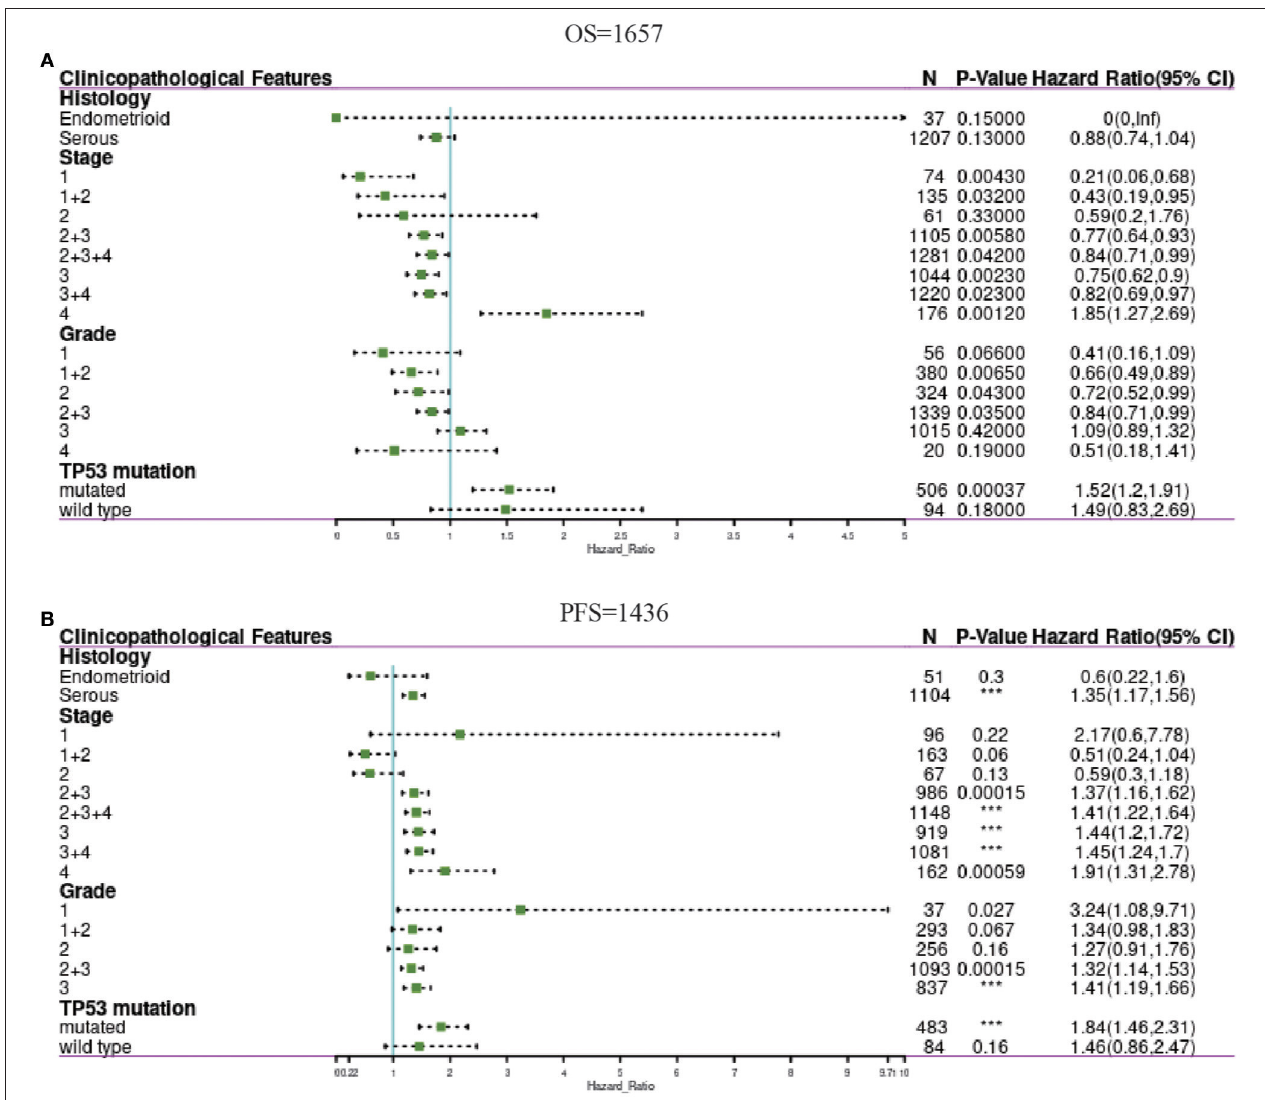
FIGURE 3 | Forest plots showing associations between PER1 expression and clinicopathological features in OV patients. The above table show correlation of PER1 expression and OS in OV with different clinicopathological factors (A) . The below table show correlation of PER1 expression and FPS in OV with different clinicopathological factors (B) . *** P <